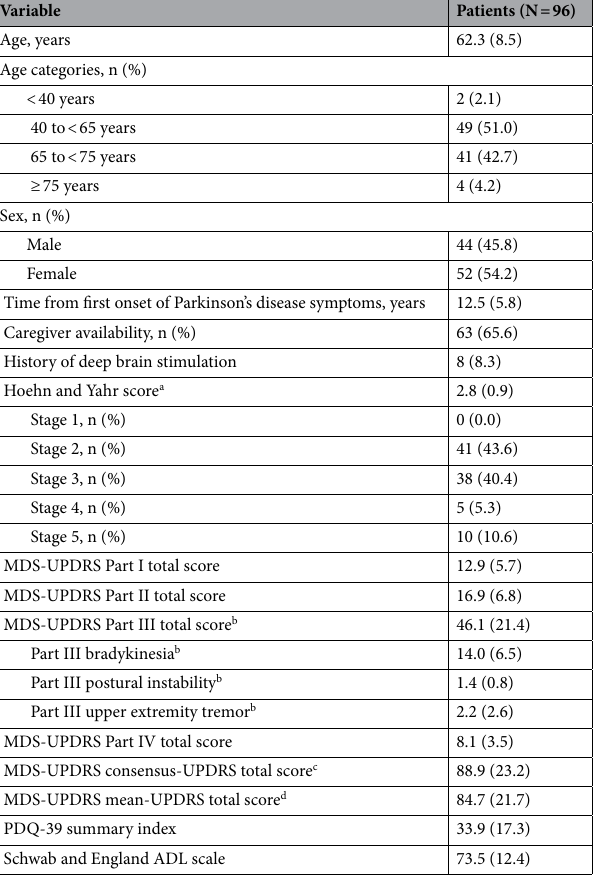
Table 1. Patient demographics and characteristics. Data are mean (SD) unless reported otherwise. a Assessed in Period 2, Day 3 of inpatient assessment, OFF state. b Assessed in Period 2, Day 2 of inpatient assessment, OFF state. c Consensus scores for the MDS-UPDRS Part III were the average of three neurologist ratings (OFF medication state). d Mean MDS-UPDRS Part III scores were calculated from scores on Days 2, 3, and 5 of